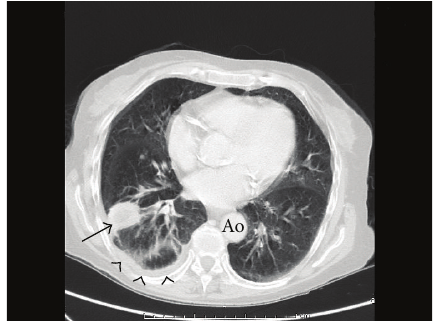
Figure 2: Computed tomography of the chest (lung window) showing a small focal consolidation within the posterior segment of the right lower lobe (arrow) and mild pleural effusion (arrowheads).